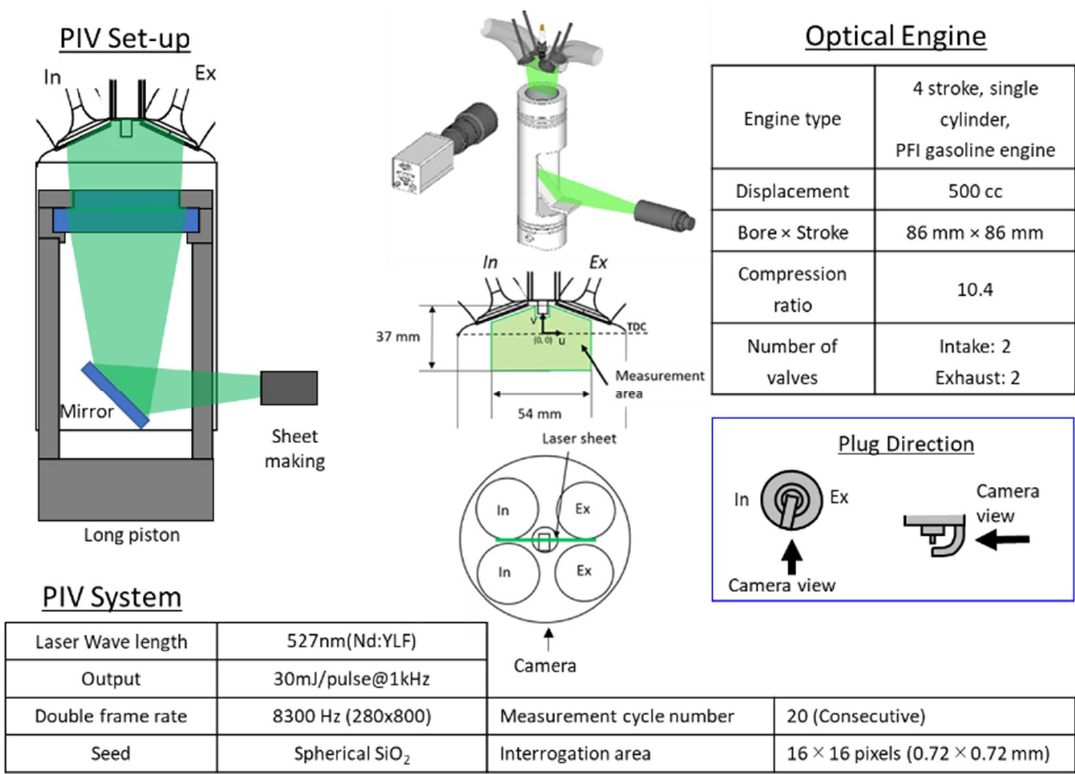
Figure 3. The optical engine specifications and the optical arrangement and measurement region of high-speed PIV measurement.